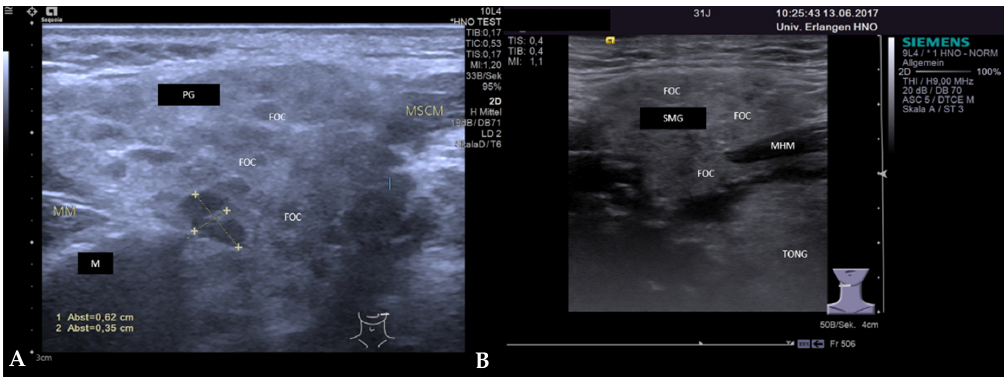
Figure 12. ( A , B ): Ultrasound findings at the early stage of M. Sjögren in the PG ( A ) and SMG ( B ). The parenchyma is slightly hypoechoic with multiple small (size 2–3 mm) and more pronounced hypo-echoic foci, which correspond to an accumulation of lymphatic cells. Glands are moderately enlarged. Abbreviations: PG, parotid gland; SMG, submandibular gland; M, mandible; MM, masseter muscle; MHM, mylohyoid muscle; MSCM, sternocleidomastoid muscle; TONG, tongue; FOC, Focus.